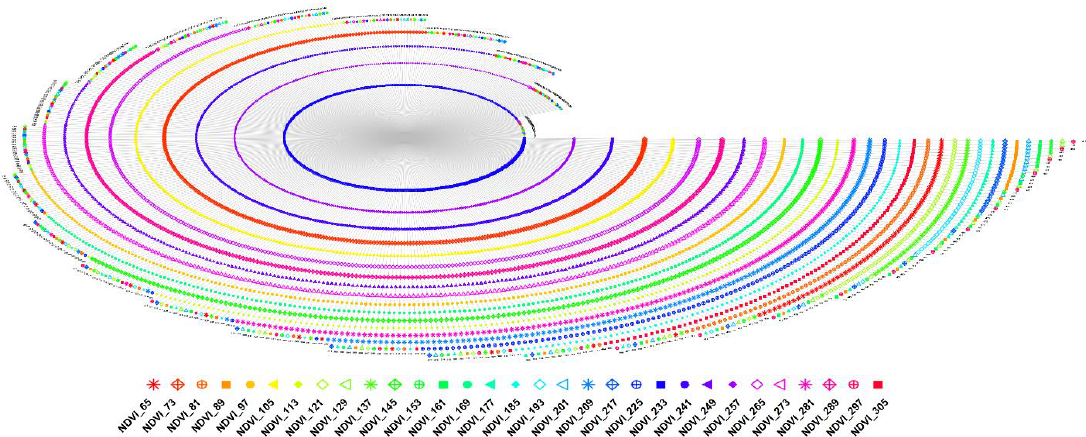
Figure 4. The iteration process of the forward stepwise strategy for selecting the optimal NDVI features (independent variables) from the thirty-one candidate NDVI variables. The dependent variable is located at the center of the vortex. Different symbol in different shape represents different NDVI temporal variable. The iteration process of the forward stepwise selection strategy starts from the first vortex circle ( inside ) and ends at the last vortex ( outside ), where the symbol with the largest amount in each vortex circle was the optimal NDVI variable of this iteration.